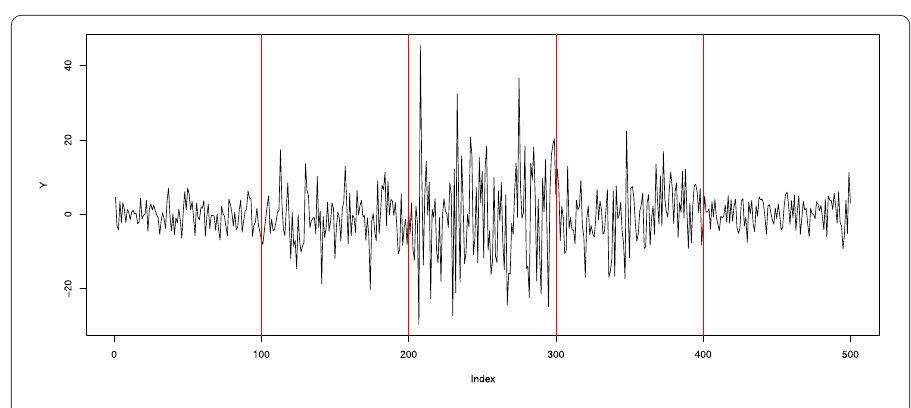
Table 1 Comparison of the MVCI algorithm with SN,PELT, BS, and WBS methods τ ∗ i n SN PELT BS WBS MVCI 0.2